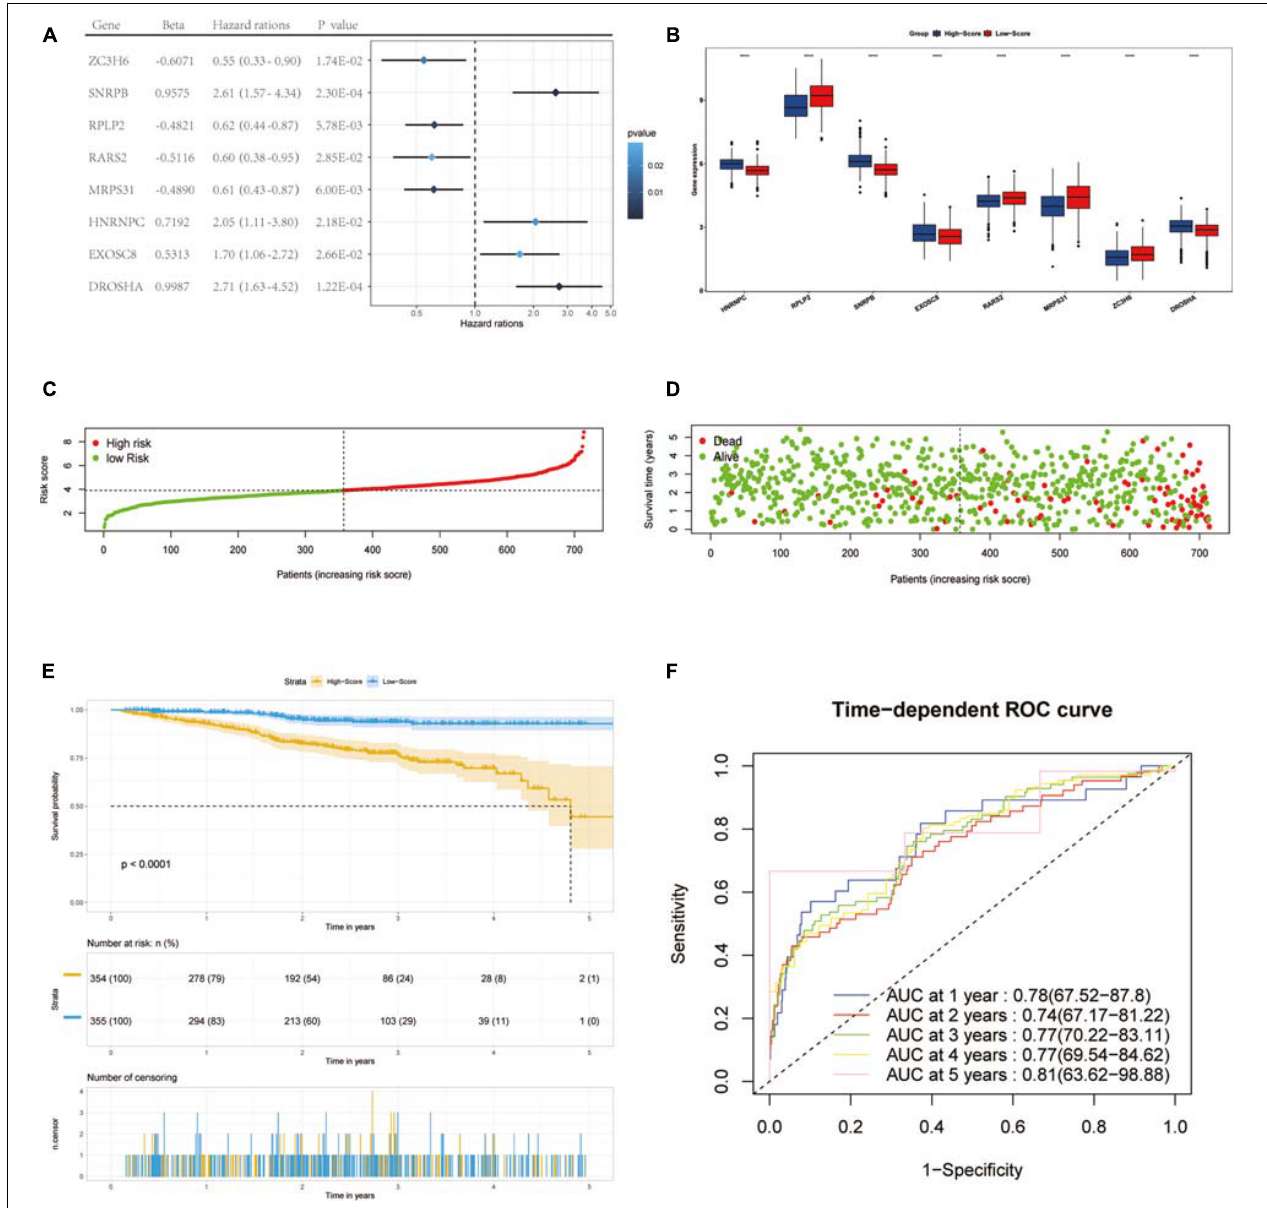
FIGURE 3 | Forest plots of the multivariate Cox regression analysis, the boxplot of eight RBP expression levels, the distribution of risk score, the living status, Kaplan–Meier analysis, and ROC analysis of the eight-gene signature of MM patients in the TCGA cohort. (A) Forest plot of the multivariate Cox regression analysis of OS of eight genes. Beta values represent the coefficient index β for each gene. (B) The boxplot of eight RBP expression levels in the training set (blue: low-score group. Red: high-score group). (C) The distribution of risk scores in the TCGA training set. (D) The living status of MM patients in the TCGA training set. (E) Kaplan–Meier survival analysis of the low-score and high-score group patients. (F) ROC curve analysis according to the 1-to-5-year survival of the area under the AUC value in the training TGCA